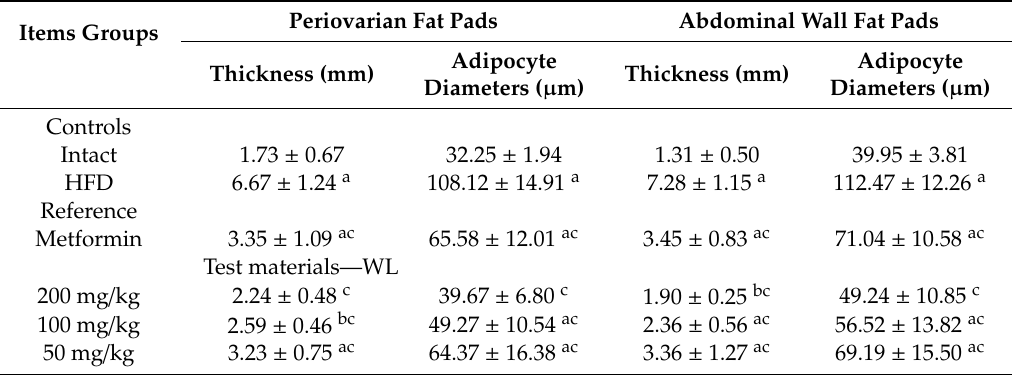
Table 3. The histopathologic and histomorphometric changes of the periovarian and abdominal wall fat pads in NFD or HFD supplied